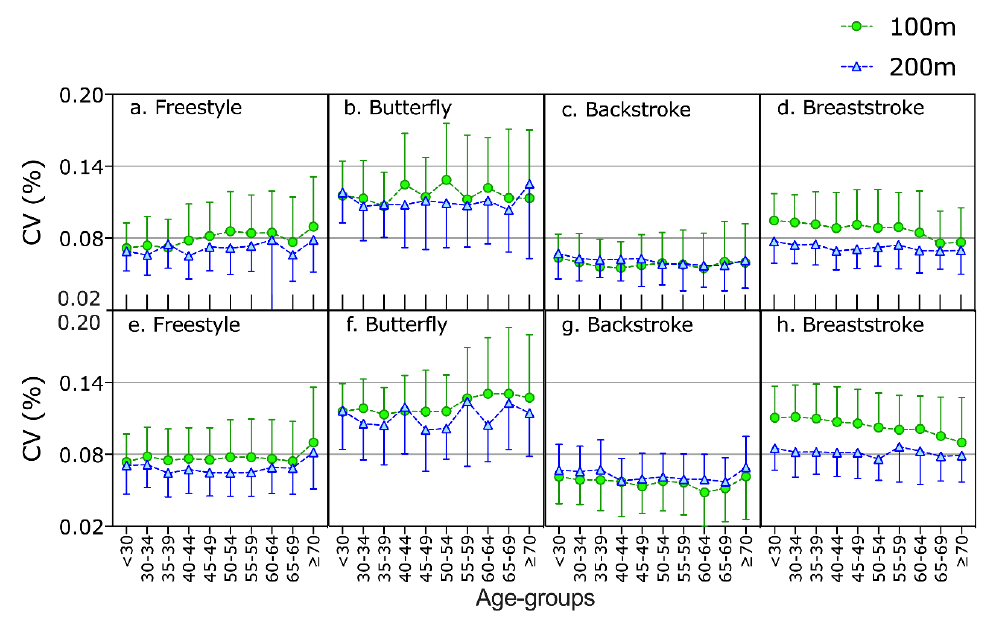
Figure 2. Individual coe ffi cient of variance of swimming speed of women ( a – d ) and men ( e – h ) in 100 m and 200 m swim races of the four strokes across age groups.